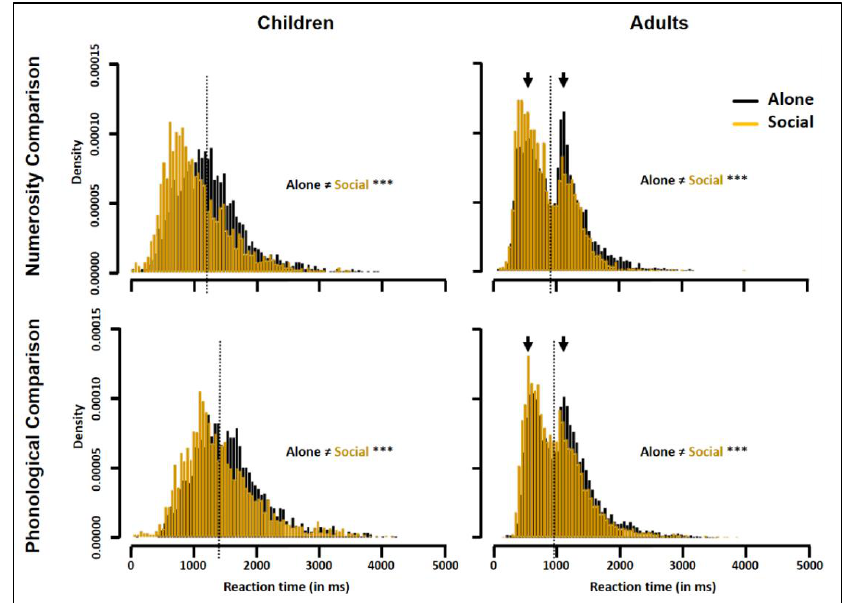
Figure 4. Group RT distribution in children ( left ) and adults ( right ) for numerosity ( top ) and phonological ( bottom ) com- parisons in the Social (yellow) compared to the Alone (black) condition. *** denote differences between the Alone and Social conditions as revealed by K-S tests ( p < 0.001). The arrows point to the 1st and 2nd peaks of the adults’ bimodal RT distribution. The dotted lines show the RT values used to separate fast from slow responders (see Figure 6). Figure 5 illustrates the ex- Gaussian parameters, μ (average RT), σ (variability in RT), and τ (extremes in RT) obtained for each trial type. The 2 (Age) × 2 (Trial type) × 2 (Con- dition) ANOVAs yielded main effects of Age and Trial type for all three parameters (all Fs(1, 190) ≥ 7.91, all ps ≤ 0.005, η p2 ≥ 0.20) as μ, σ, and τ were longer in childre n than in adults, and longer for phonological than for numerosity comparisons. For µ, there was in addition a main effect of Condition (F(1, 190) = 11.06, p = 0.001, η p2 = 0.06) without interac- tion with other factors. For σ, there was a main effect of Cond ition (F(1, 190) = 4.19, p = 0.04, η p2 = 0.02) qualified by a Condition × Age interaction (F(1, 190) = 4.10, p = 0.04, η p2 = 0.02). For τ, there was no effect of Condition, and no interaction. Figure 5. Ex-Gaussian decomposition of RTs into average performance ( µ ), variability in performance ( σ ), or extremes in performance ( τ ). Data points are means + SEM. Symbols denotes results from Student’s t -tests with the Bonferroni adjust- ment for multiple comparison: the asterisks indicate differences between the Social and Alone conditions (* p < 0.05, ** p <